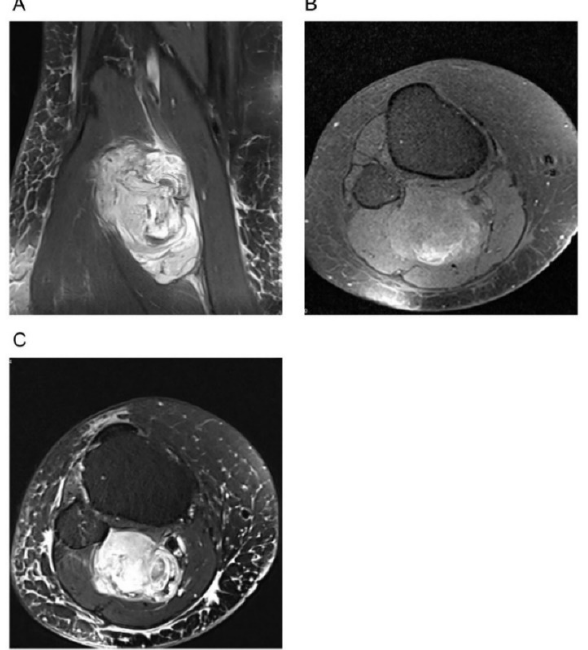
Figure 5. Initial MRI describing a suspected schwannoma; histology after resection confirmed malignant peripheral nerve sheath tumor (MPNST). ( A ) Coronal proton density (PD) sequence. ( B ) Axial fat-saturated T1 sequence without contrast agent. ( C ) Axial T2 sequence .